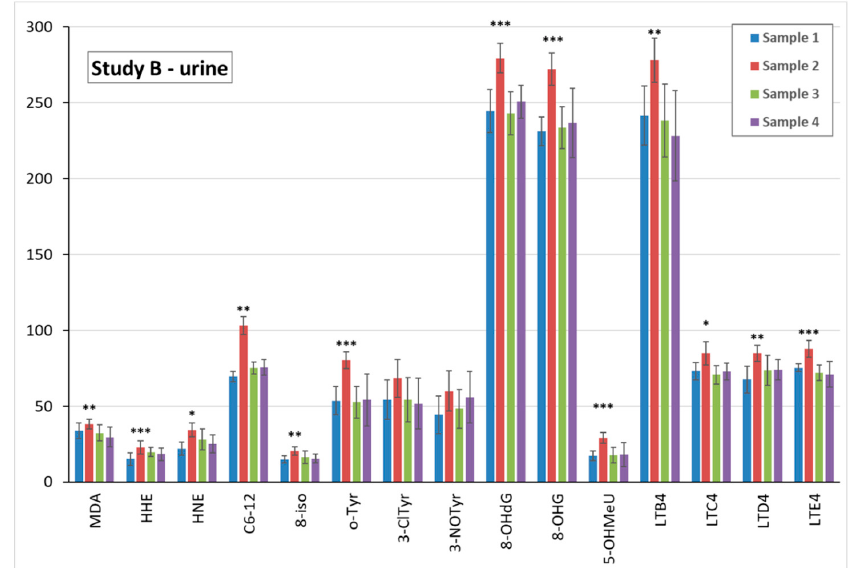
Figure 4. Comparison of the mean levels of oxidative stress and inflammatory markers in study B urine pre-exposure (sample 1) and after UV exposure (samples 2–4). * ( p < 0.05) ** ( p < 0.01) *** ( p < 0.001). MDA = malondialdehyde, HHE = 4-hydroxy- trans -hexenal, HNE = 4-hydroxy- trans -nonenal, C6-12 = aldehydes C6-C12, (all ng/mL); 8-iso = 8-isoProstaglandin F2 α , 8-OHdG = 8-hydroxy-2-deoxyguanosine, 8-OHG = 8-hydroxyguanosine, 5-OHMeU = 5-hydroxymethyl uracil, o-Tyr = o-tyrosine, 3-ClTyr = 3-chlorotyrosine, 3-NOTyr = 3-nitrotyrosine, leukotrienes (LT) LTB4, LTC4, LTD4, LTE4 (all pg/mL).